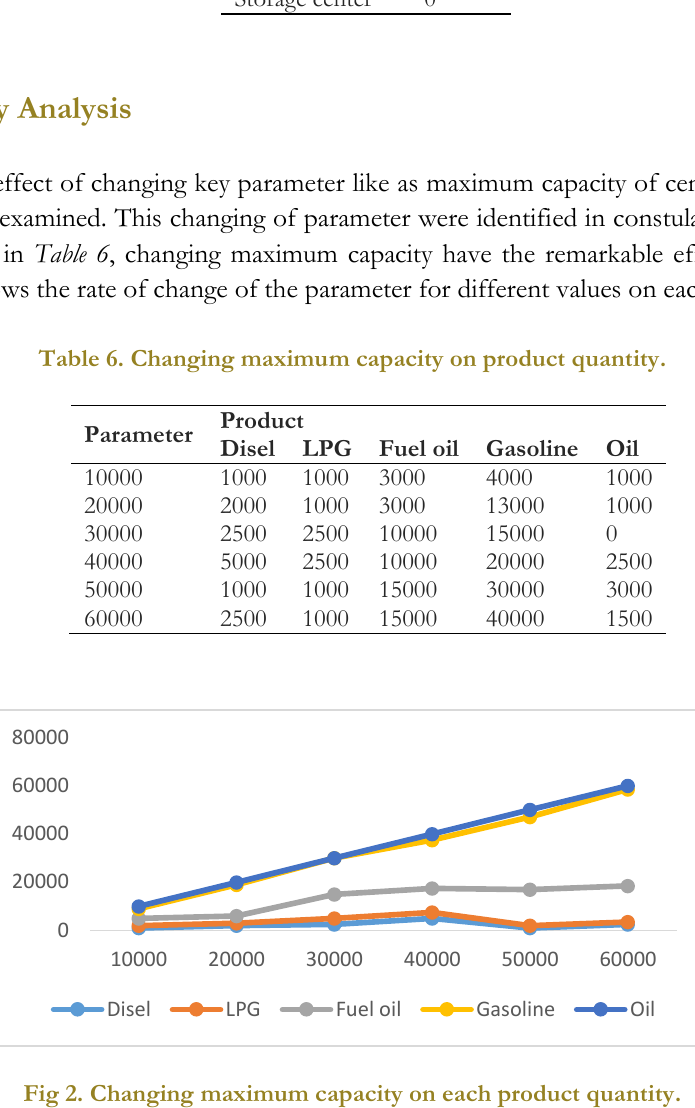
Fig 2. Changing maximum capacity on each product